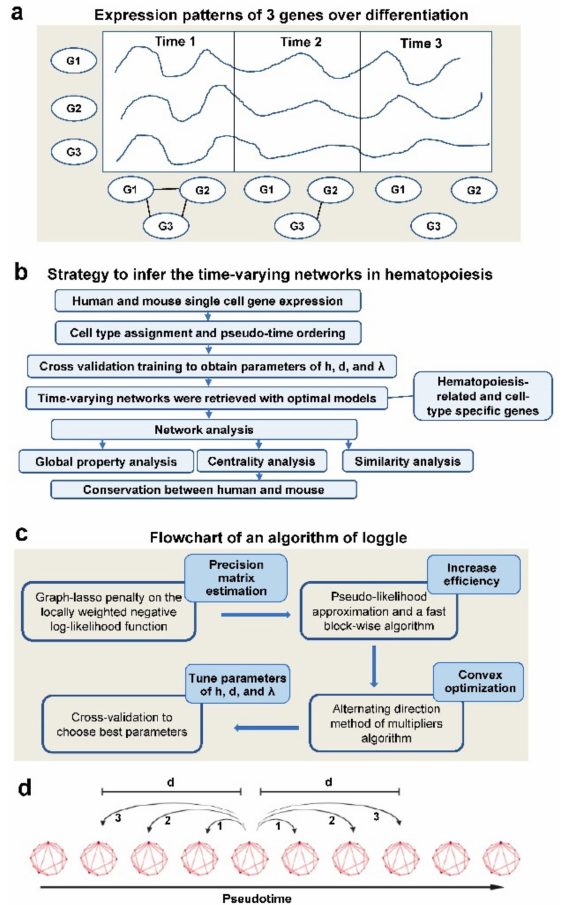
Figure 1. ( a ) Hypothetical model of three genes’ expression patterns with differentiation, from which we inferred a time-varying network and a network change over time. Correlations were inferred from expression at time points and neighboring time points. Three genes were corelated at time point 1. Only G2 and G3 were correlated at time 2, and there was no correlation at time 3. ( b ) Strategy to infer the time varying network in hematopoiesis. ( c ) A flowchart of an algorithm of the LOGGLE, with improvement with the ADMM approach. ( d ) Scheme of neighboring width d for the lasso-type penalty function, pseudo-time is the inferred pseudo-time of the cell at the center of each